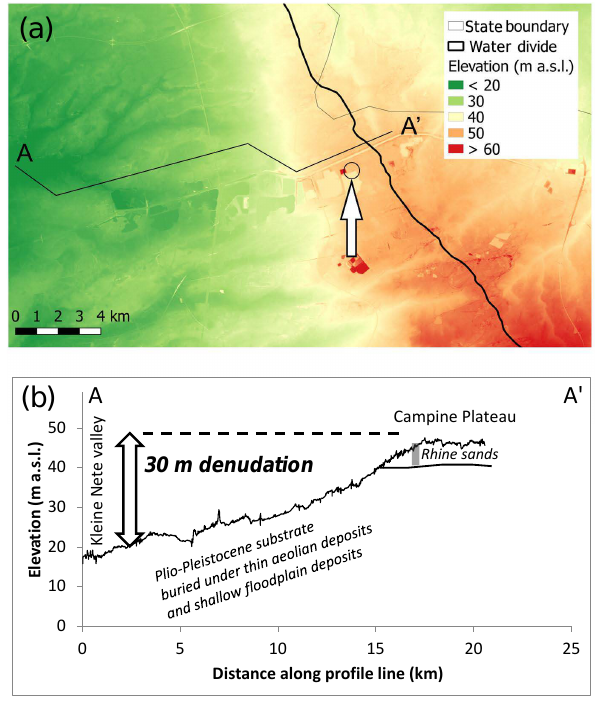
Figure 4. (a) Detailed DTM of the study area (Digitaal Hoogte- model Vlaanderen II, DTM, raster, 1m), with indication of the sam- pling location (white arrow). Note the regularly shaped sand quar- ries south of profile line A-A’ which appear as depressions on the DTM. (b) Topographic cross section according to the profile line (A-A’) shown in (a) . The sampling location is schematically shown as a gray